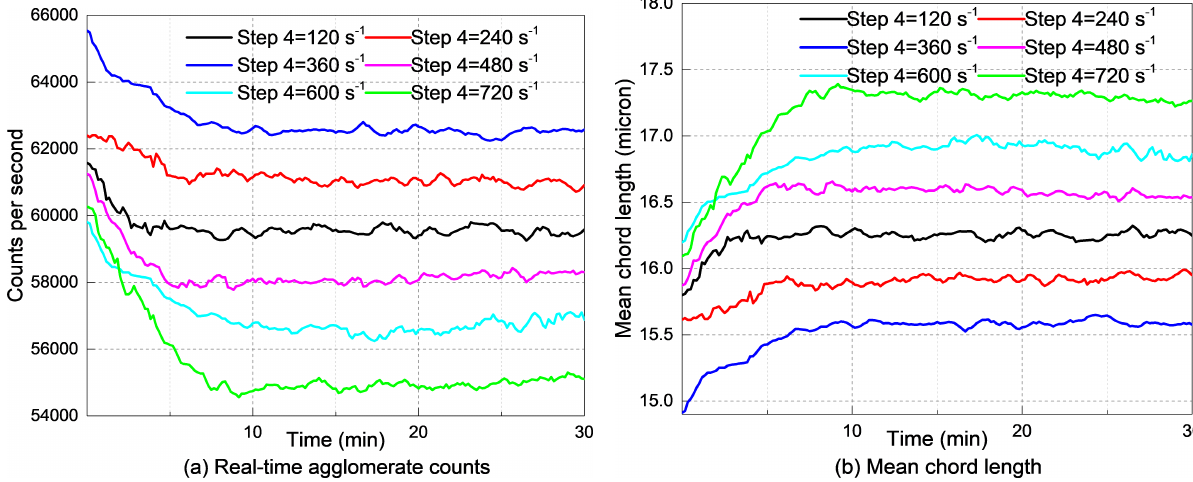
Figure 13: Effect of shear history on fresh state agglomerate condition for CPB-D.